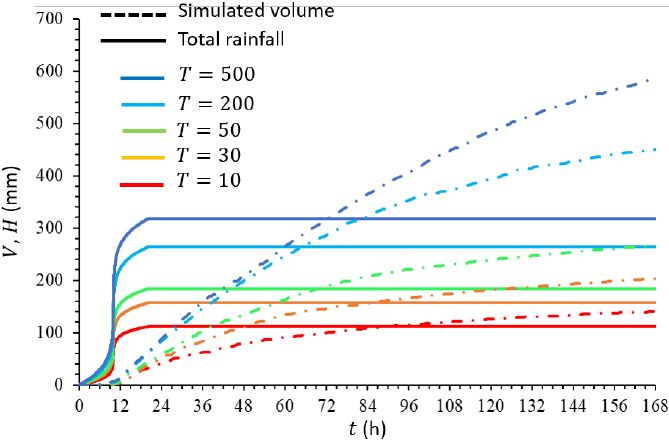
Figure 9. Synthetic design events: comparison between the pumped water volumes (per unit catchment area) and the total design rainfall at the Bagnolo pumping station for different return periods T .